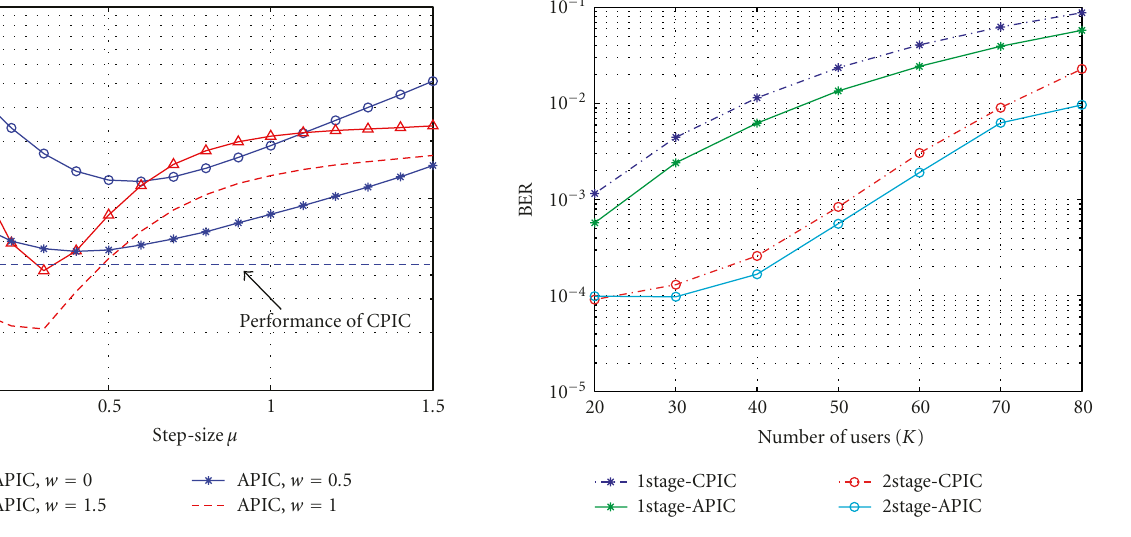
Figure 8: BER performances of the CPIC versus the APIC. N = 32, SNR = 20dB. For the APIC, μ 1 = 0 . 3, μ 2 = 0 . 05.